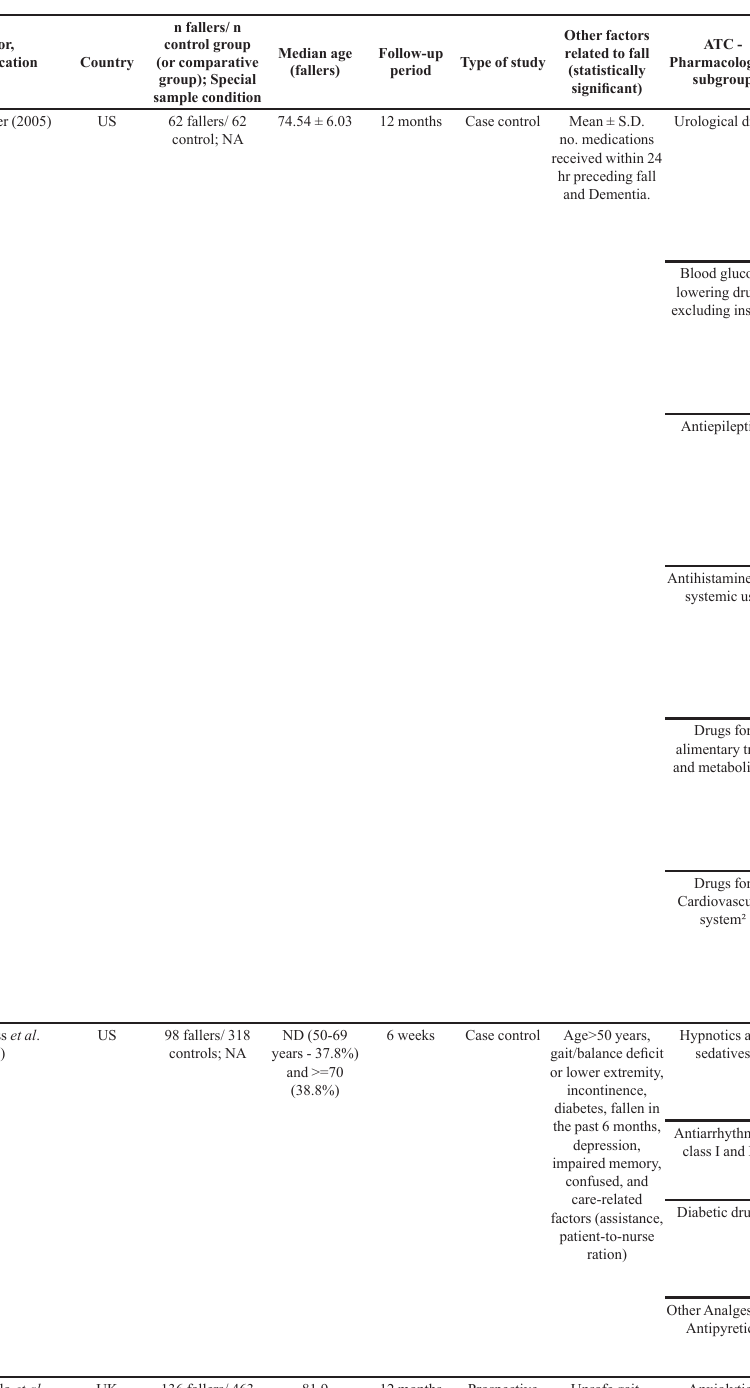
TABLE III - Eligible studies data